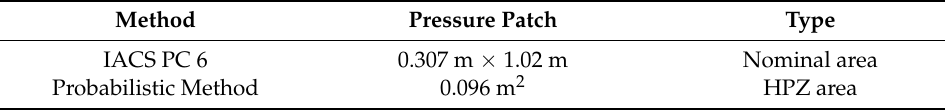
Table 5. Dimensions of pressure patches calculated using various